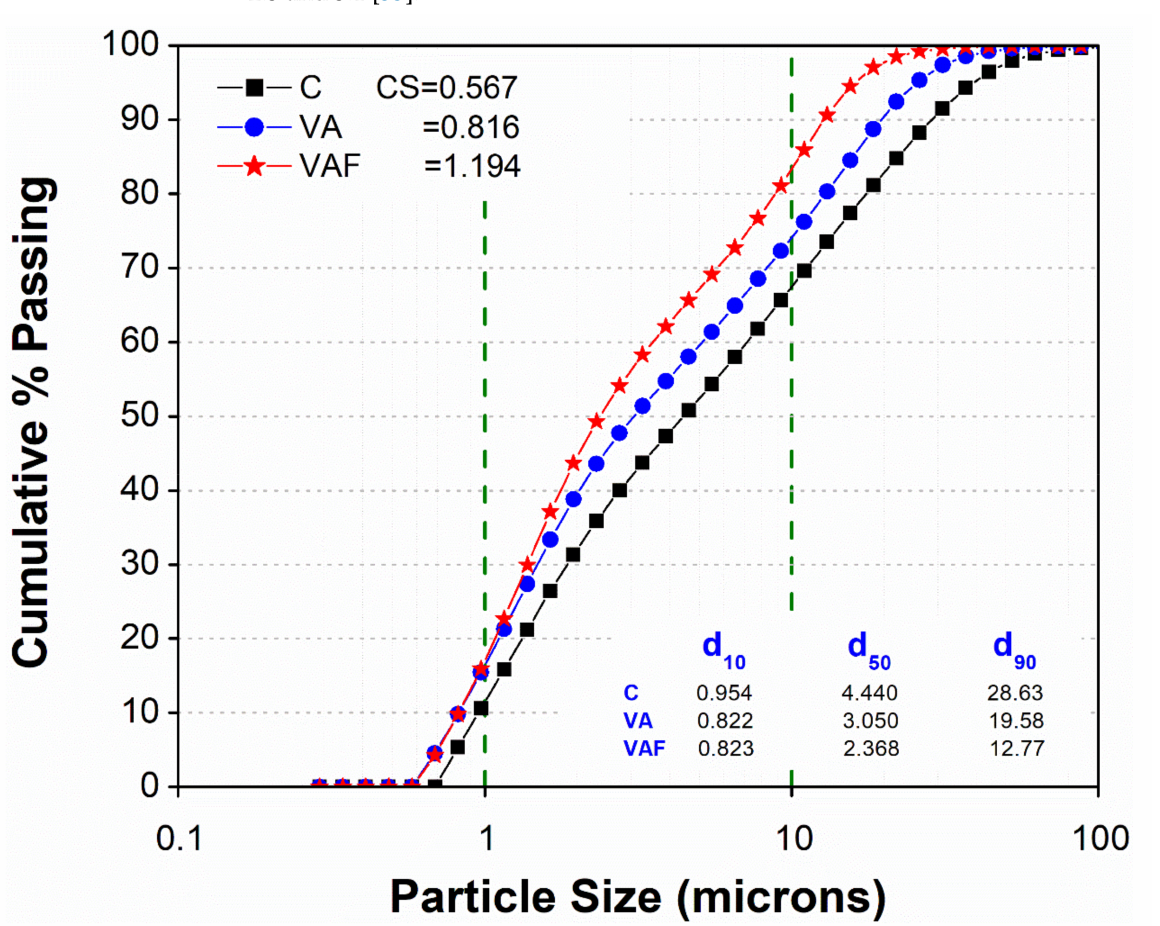
Figure 3. Particle size distribution curves of cement, fine volcanic ash, and ultra-fine volcanic